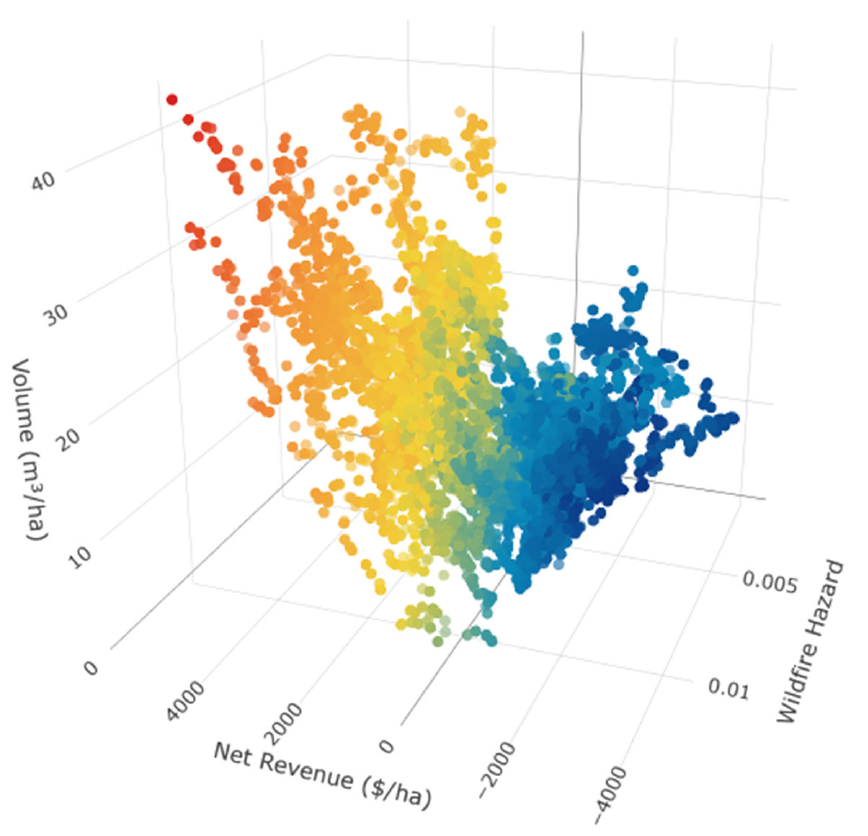
Figure 4. Plot of the 22,166 different 300 ha feasible project configurations. Fire hazard, harvest volume, and net revenue objective contributions are presented per hectare, due to the ± 10% variation in project size.